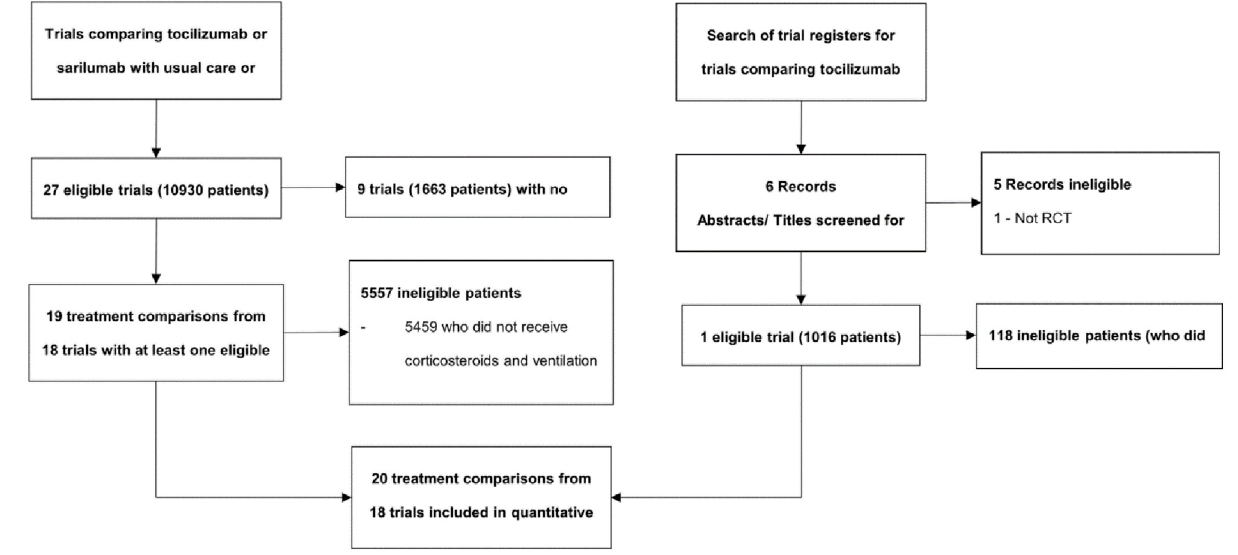
Fig 1. Flow diagram showing the identification of eligible trials and